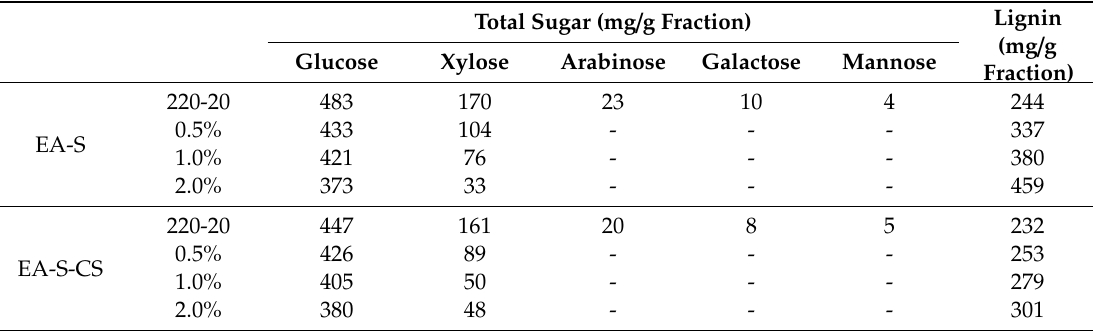
Table4. SugarcontentofpretreatedEFBsolidfractionsunderdi ff erenttemperaturesandresidencetimes.